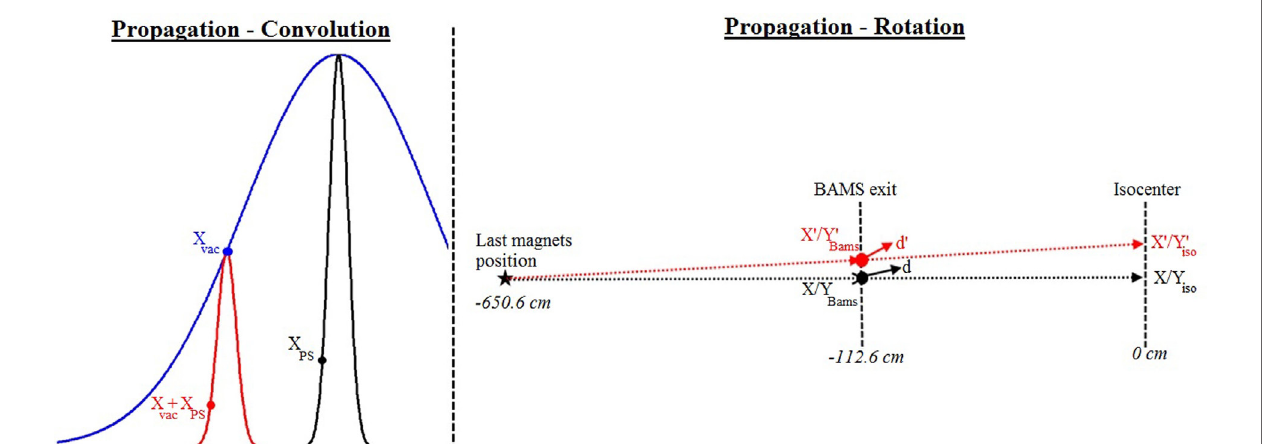
FigUre 2 | Propagation process: on the left panel, convolution results (red) between the Ps from the narrow beam (black) and the gaussian in vacuum (blue): new position ( X vac + X Ps ) obtained from the original position on the phase space ( X Ps ) and the selected position on the gaussian in vacuum ( X vac ); on the right panel, rotation of the beam to the expected position: transformation from the X / Y position at the BaMs with a direction cosine d to the new X ’ Bams / Y ’ Bams position at the BaMs with the direction cosines d’ in order to reach the X ’ iso / Y ’ iso position at isocenter